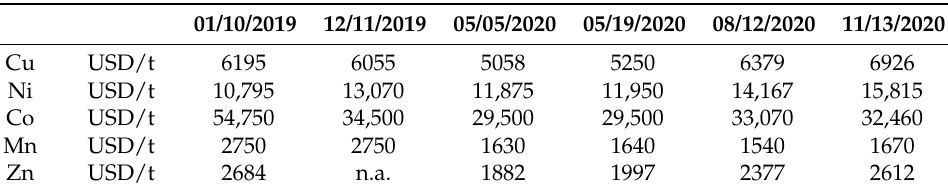
Table 12. Metal prices in the last two years (sources: London Metal Exchange LME [34], Metal Bulletin [35]).